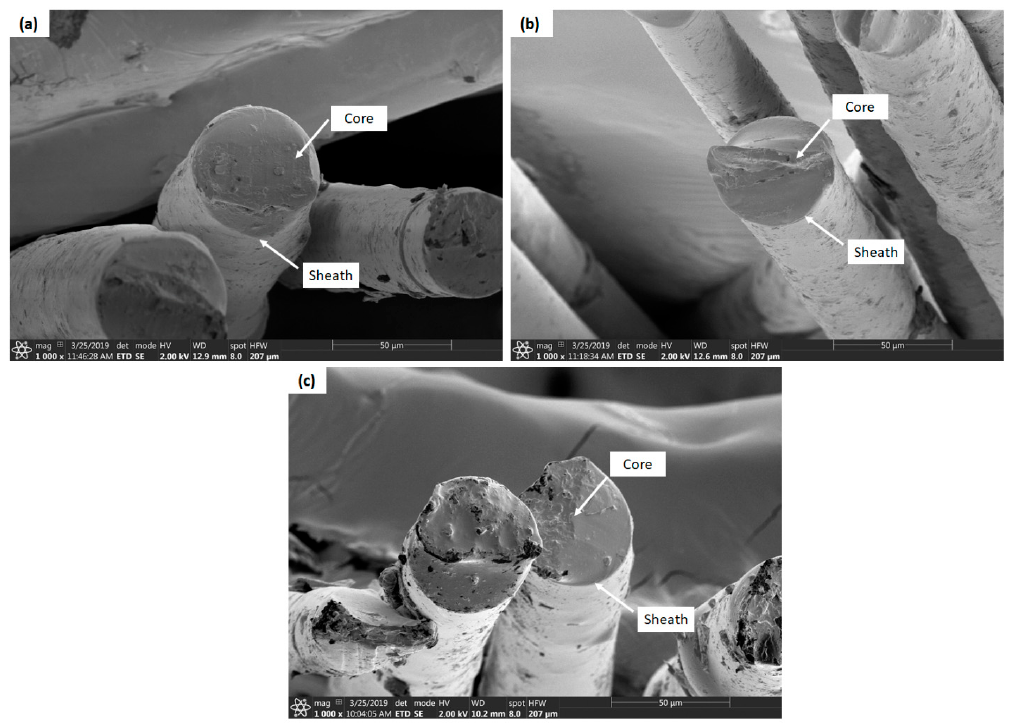
Figure 5. Cross-sectional SEM images of PLA / APP5 / PES10 / KL1 ( a ), PLA / APP5 / PES10 / KL3 ( b ), PLA / APP5 / PES10 / KL5 ( c ), bicomponent composite fibers [1000 × and 50 µ m]. Materials 2019 , 12 , x FOR PEER REVIEW